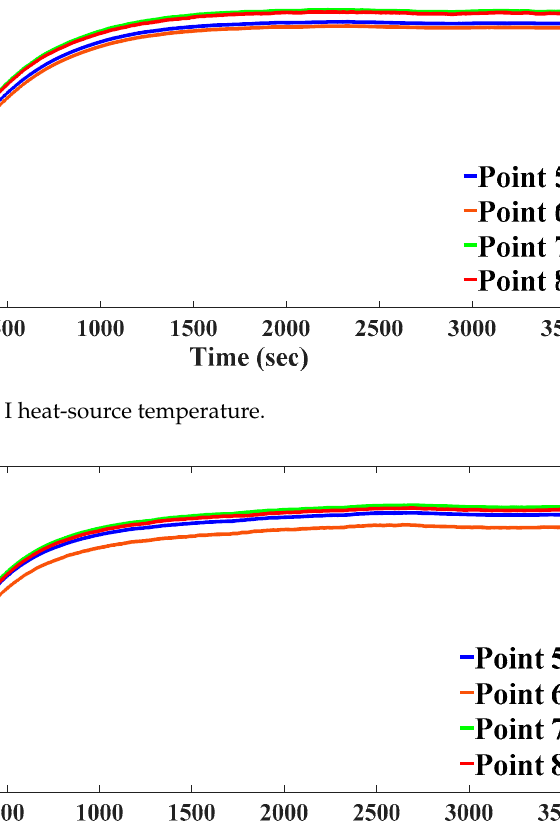
Figure 25. Temperature responses in Type II Upper-plate point.